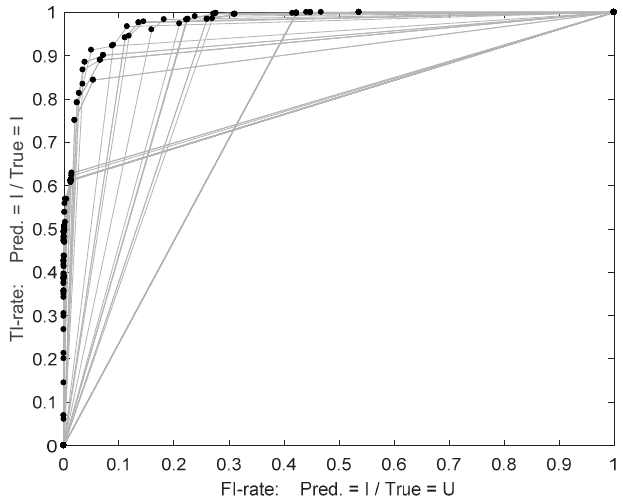
Figure 8. ROC curves (x: false alarm rate (FI)/y: sensitivity (TI)) obtained for different misclassification costs (cost ratio between 1:10 − 4 and 1:10 4 for the FI and FU costs).